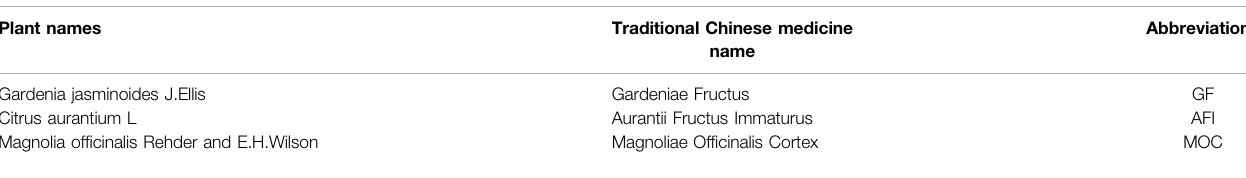
TABLE 1 | Components of